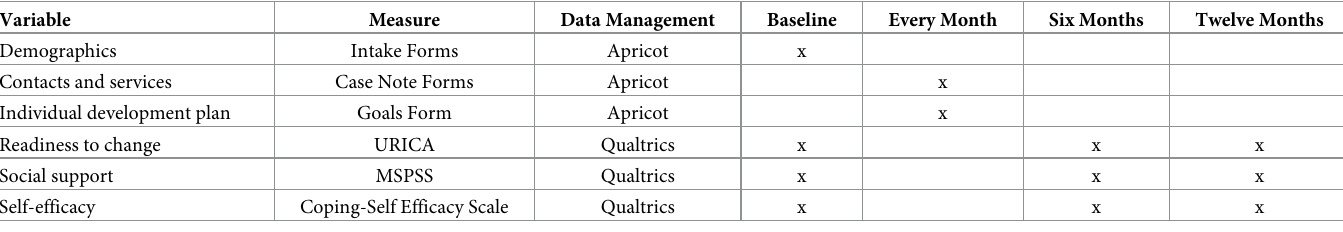
Table 1. Measures administered to clients by time